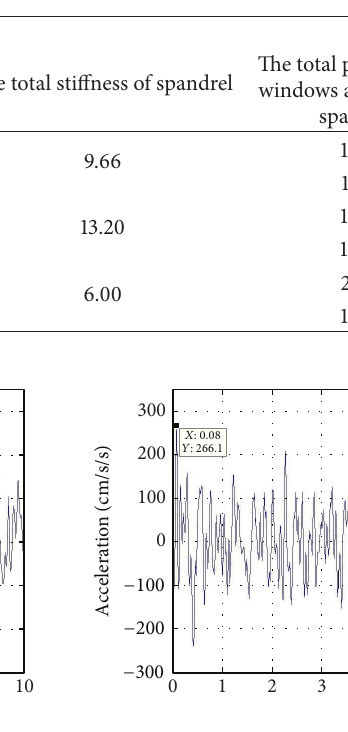
Table 4: The stiffness ratio of pier between windows and spandrel.